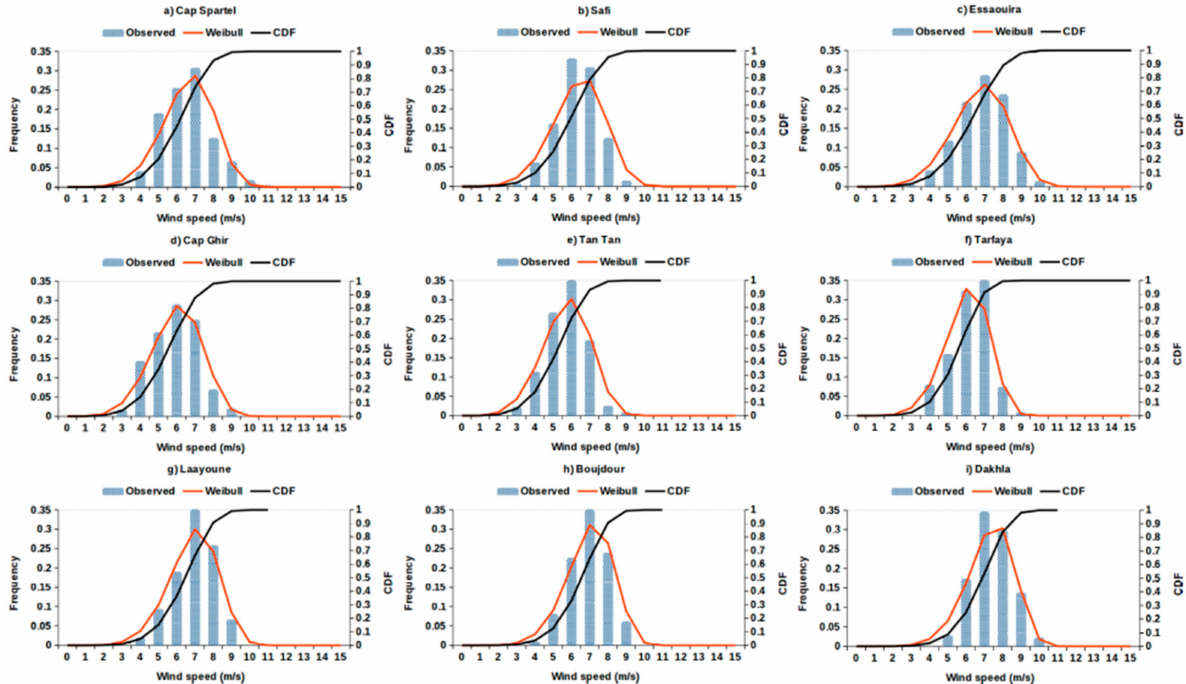
Figure 8. Climatological comparison of the observed and the predicted wind speed frequencies associated with the cumulative distribution function for the nine